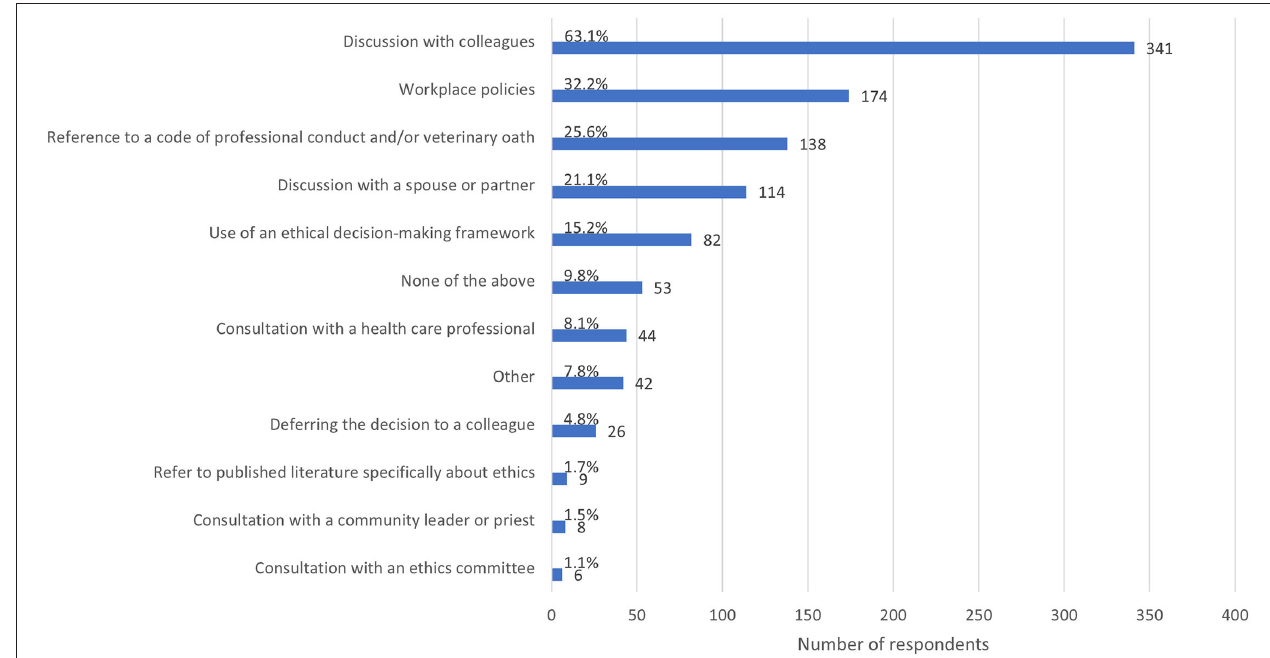
FIGURE 5 | Bar chart of the frequency of the resources and strategies used by veterinary team members when faced with the most recent ethically challenging situation they have encountered, based on the responses of 540 veterinarians, animal health technicians and veterinary nurses, surveyed between May and July in 2020. Note that respondents could select multiple